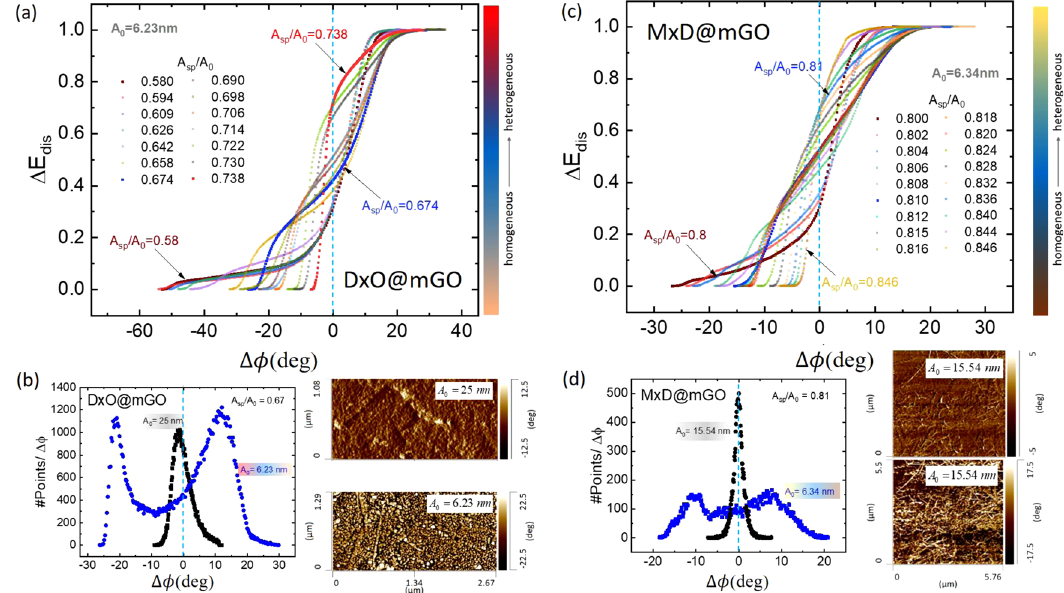
Fig. 3 Normalized cumulative density graphs of phase histograms. a DxO@mGO and c MxD@mGO at low A 0 depicting the net dissipated energy from the fl uctuational probability transitions at light tapping in the limit Δ ϕ ! 0. The two-level transition originates from both heterogeneous and homogeneous energy losses. Phase images of b DxO@mGO and d MxD@mGO at low and high amplitudes and comparable A sp / A 0 ratios. The absence of the secondary heterogeneous transition at higher A 0 = 25 and 15.54 nm (traditional hard tapping) is apparent. The histogram peaks in ( b ) and ( d ) highlight the separation of the timescales in the underlying dynamics accentuated by the fl uctuations. The transitions at A 0 = 25 and 15.54 nm are centered at 0 with a positive Δ ϕ skew signifying an apparent contact regime